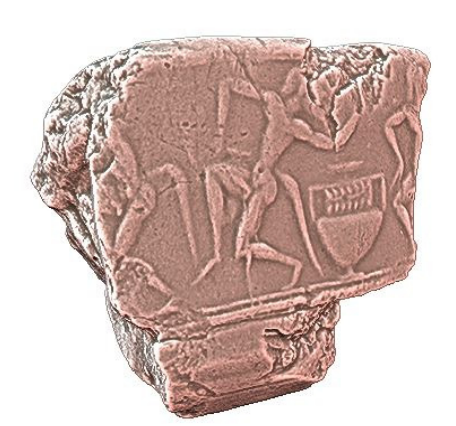
Figure 21. Digital visualization of the fragment with Komòs